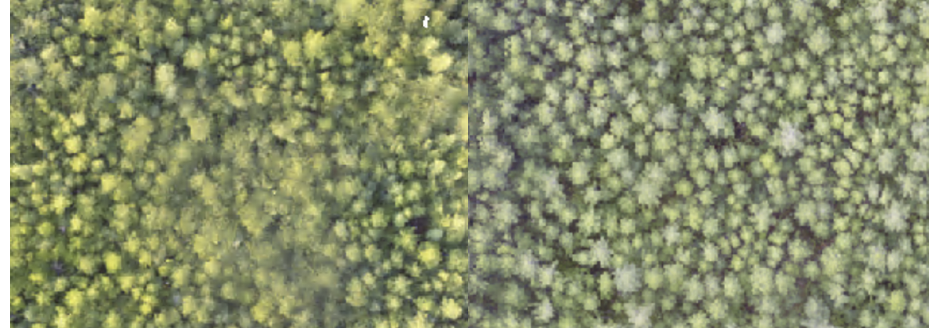
Figure 22. Dense forest red–green–blue (RGB) orthomosaics for plots EN18077 and